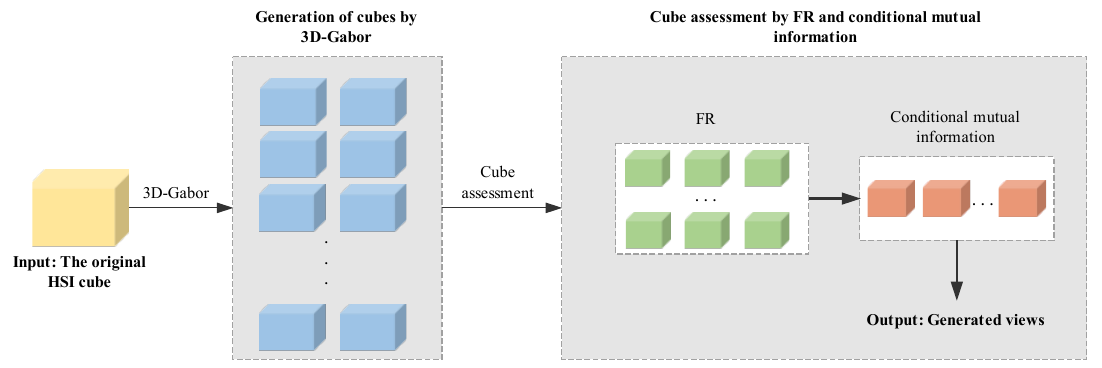
Figure 2. The general view generation approach